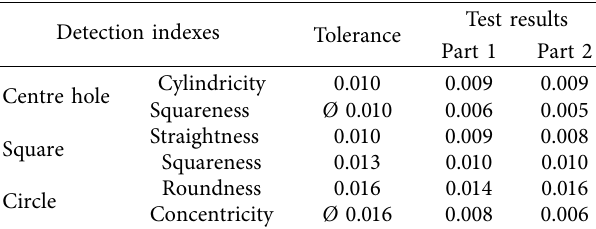
Part 1 (Without comp.) Part 2 (With comp.) Figure 11: Parts machined without and with error compensation. Table 6: Comparison of the measured results of the machined parts